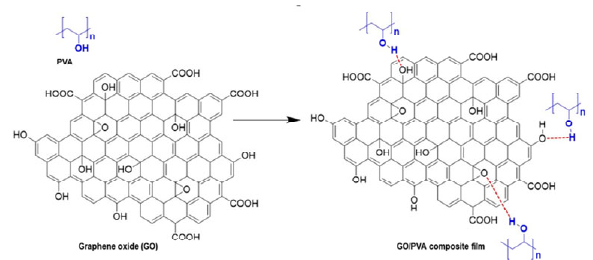
Fig. 1 Molecular structure of the GO before and after the intercalation with the